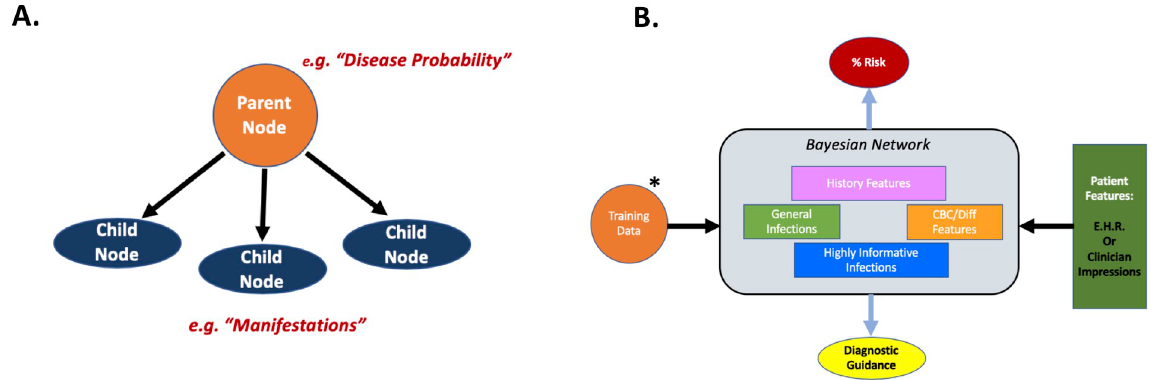
Fig 1. Bayesian network structure. A . An example Bayesian network with parent and child nodes connected by arcs. B . The general structure of our network components. Training data ( � may be updated over time) and patient features allow for improving inference (i.e. probabilities) and structure over time making these networks dynamic. (EHR = Electronic Health